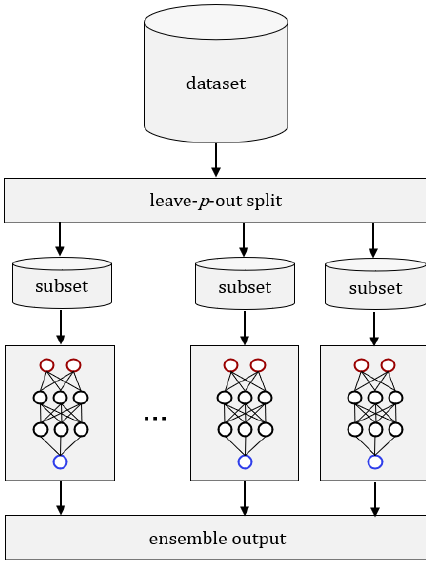
Figure 11. Visualization of the ensemble modeling concept using a leave- p -out technique for generating